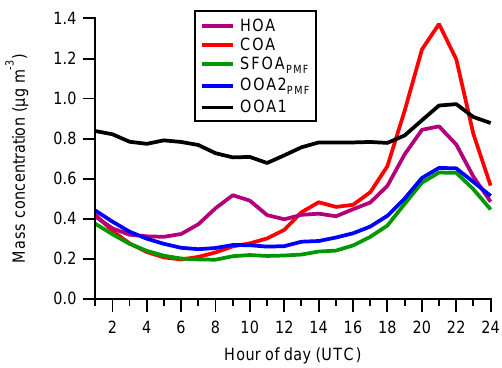
Figure 3. Median diurnal profiles for each of the five PMF factors. Note that these data do not include a period from the summer (see Sect.